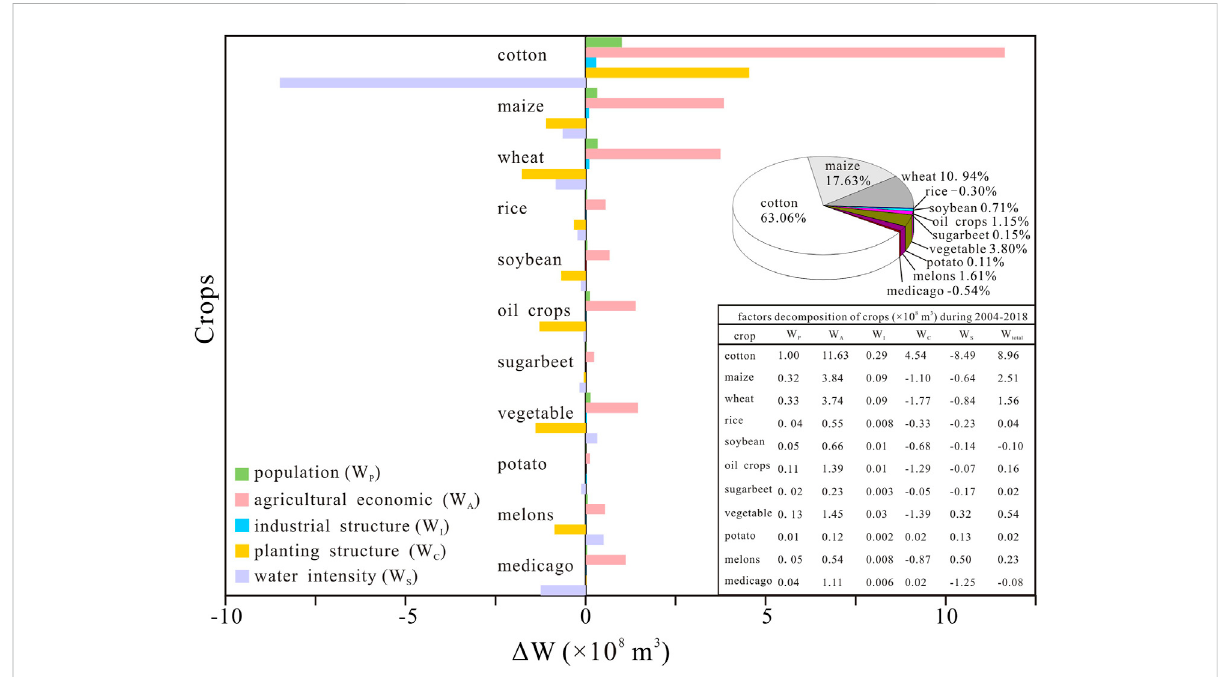
FIGURE 11 DecompositionanalysisofchangesinWFofdifferentcropsfrom2004to2018.Note:theexploredpiechartrepresentscontributionofdifferent crop WF; the table lists the results of LMDI factor decomposition for different